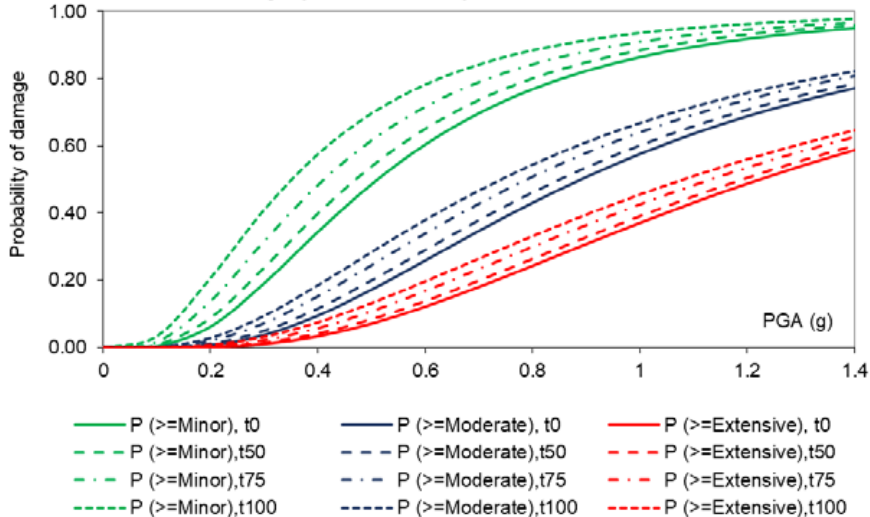
Figure 13. Analytical fragility curves developed by Argyroudis et al. [66] for segmental circular tunnels in soft soil (soil class D), for various damage states and various scenarios regarding corrosion (i.e., t0 = 0 years, t50 = 50 years, t75 = 75 years, t100 = 100 years after initiation of corrosion).